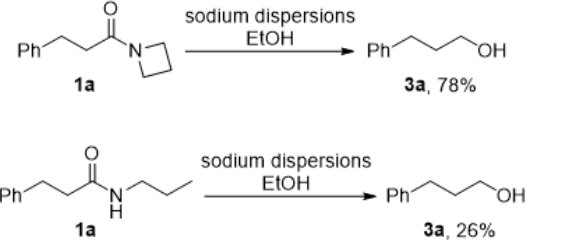
Figure 1. Selective C - N σ bond cleavage in azetidinyl amides by Na/15-crown-5 1 . 1 Conditions: 1 (0.50 mmol, 1.0 equiv.), Na dispersions (5.0 equiv.), 15-crown-5 (5.0 equiv.), THF (3.0 mL), 0 ℃ . 2 Isolated yield. 3 Na dispersions (8.0 equiv.) and 15-crown-5 (8.0 equiv.) were used.